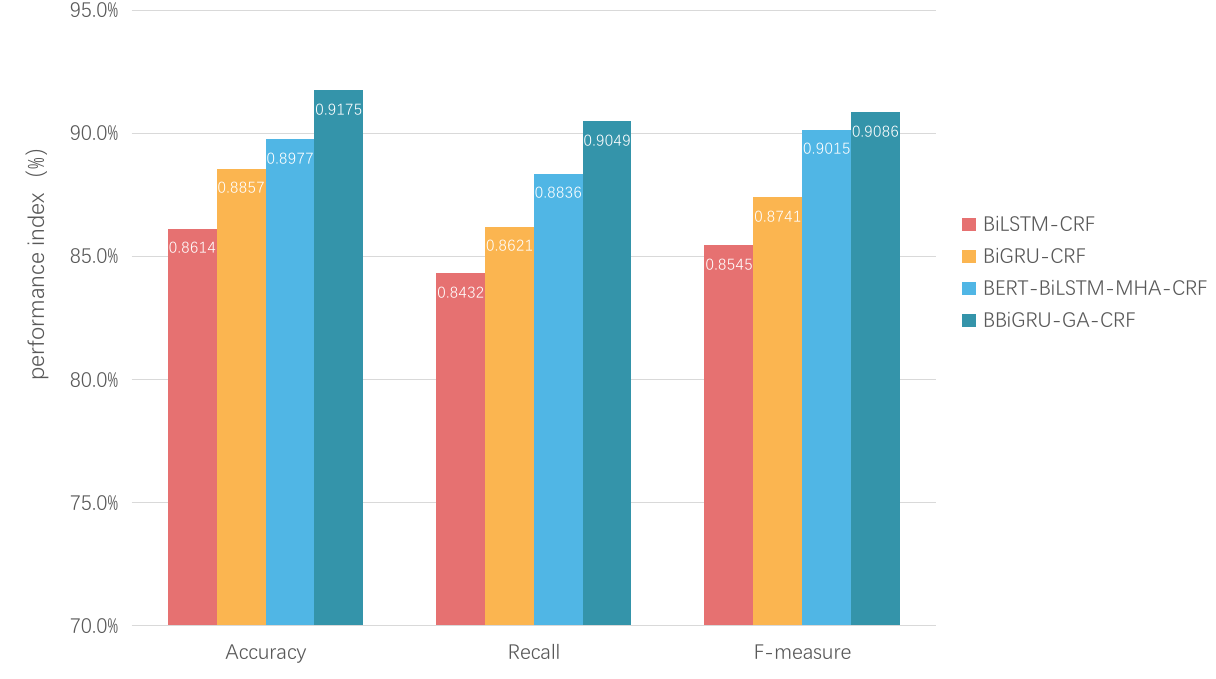
Figure 12. Experimental results of entity extraction model performance comparison.